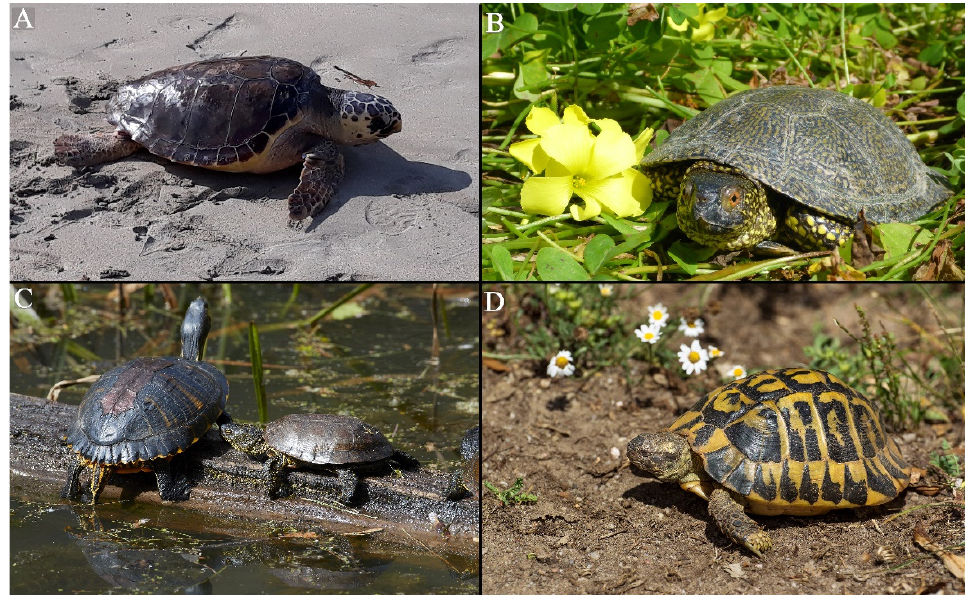
Figure 1. Native and non-native Testudines species in Sicily. ( A ) Caretta caretta from Trapani. ( B ) Emys trinacris from “Gorgo Lungo” at the Oriented Nature Reserve “Bosco della Ficuzza, Rocca della Busambra, Bosco del Cappelliere e Gorgo del Drago” (Godrano, province of Palermo). ( C ) Trachemys scripta and Emys trinacris from “Gorgo Lungo” at the Oriented Nature Reserve “Bosco della Ficuzza, Rocca della Busambra, Bosco del Cappelliere e Gorgo del Drago” (Godrano, province of Palermo). ( D ) Testudo hermanni hermanni from “Gorgo Lungo” at the Oriented Nature Reserve “Bosco della Ficuzza, Rocca della Busambra, Bosco del Cappelliere e Gorgo del Drago” (Godrano, province of Palermo). Photo by Enrico Di Girolamo ( A ), Melita Vamberger ( B ), and Domenico Margarese ( C , D ).